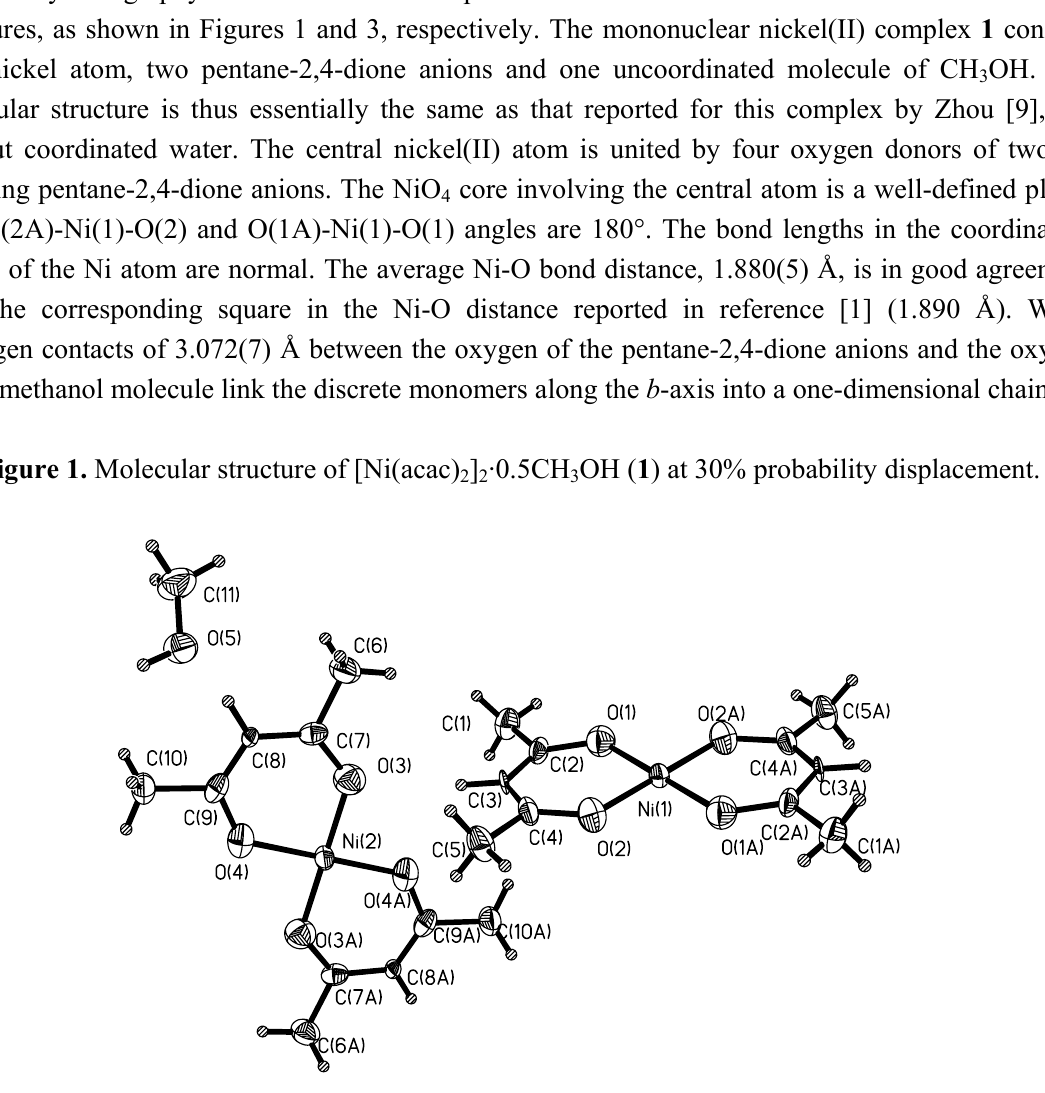
Figure 1. Molecular structure of [Ni(acac)